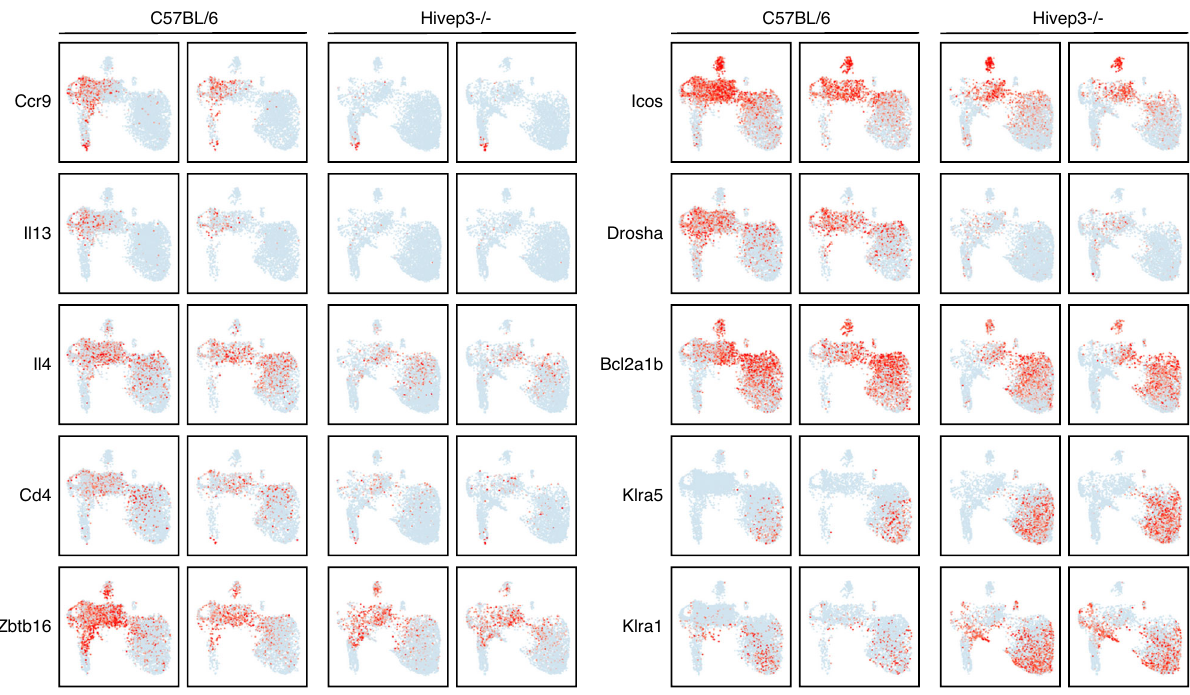
Fig. 6 Expression pro fi les of genes differentially expressed between C57BL/6 and Hivep3 − / − iNKT cells by scRNA-seq. Expression of selected genes in the C57BL/6 and Hivep3 − / − single cell RNA-seq samples. Each dot represents one cell and gene expression is plotted along a colorimetric gradient, with red corresponding to high